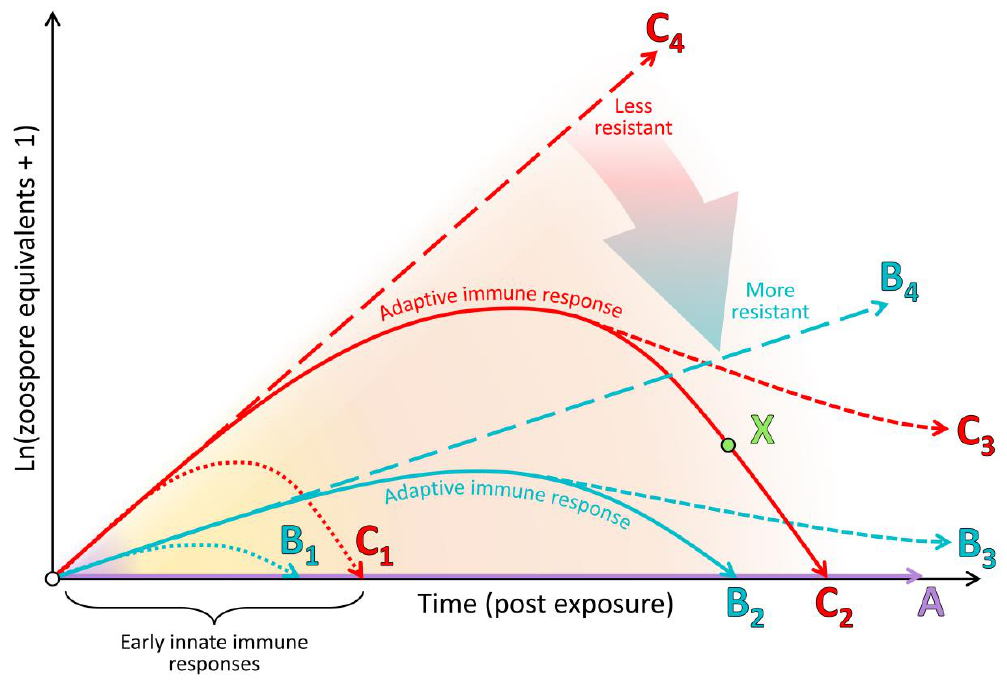
Figure 4. Schematic depicting the expected infection load trajectories against time post exposure and infection outcomes associated with di ff erent types of immune responses. Type A individuals (purple) possess fully e ff ective constitutive defences, are completely resistant and do not develop infection. Type B individuals (cyan) have partially e ff ective constitutive defences and induced innate defences, reducing their overall pathogen growth rate throughout the course of the infection (demonstrating greater resistance than type C individuals (red)). Type B individuals with su ffi ciently e ff ective early innate immune responses (corresponding to the period depicted by the yellow background band) may either (1) recover (B 1 ), or (2) survive long enough to develop an adaptive immune response (orange background band), from which they might then (3) recover (B 2 ) or (4) remain infected (B 3 ). (5) Finally, if their adaptive immune response is ine ff ectual, their infection trajectory may continue to increase (B 4 ) until they succumb to the infection. Type C individuals do not possess e ff ective constitutive defences; therefore, their native infection trajectory follows an exponential pathogen growth rate. If and when their induced innate and / or adaptive responses occur, similarly to type B, they may depart from this trajectory and either recover or remain infected (C 1–3 ). Alternatively, if the immune responses are entirely ine ff ective, the infection burden will increase exponentially until the host succumbs to infection (C 4 ). Importantly, individuals may die from infection at any point during any of the above-described infection trajectories due to immunopathology (e.g., it is entirely possible for individuals of type C to die at point X, despite a declining infection